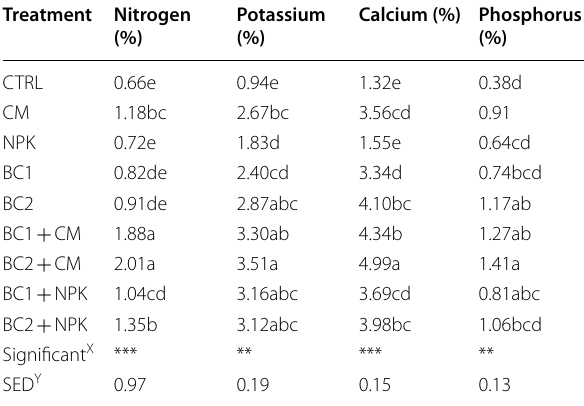
Table 9 Effect of biochar, farmyard manure compost and inorganic fertilizer on the dry matter percentage of total N, P, K and Ca in the collard leaf after harvest